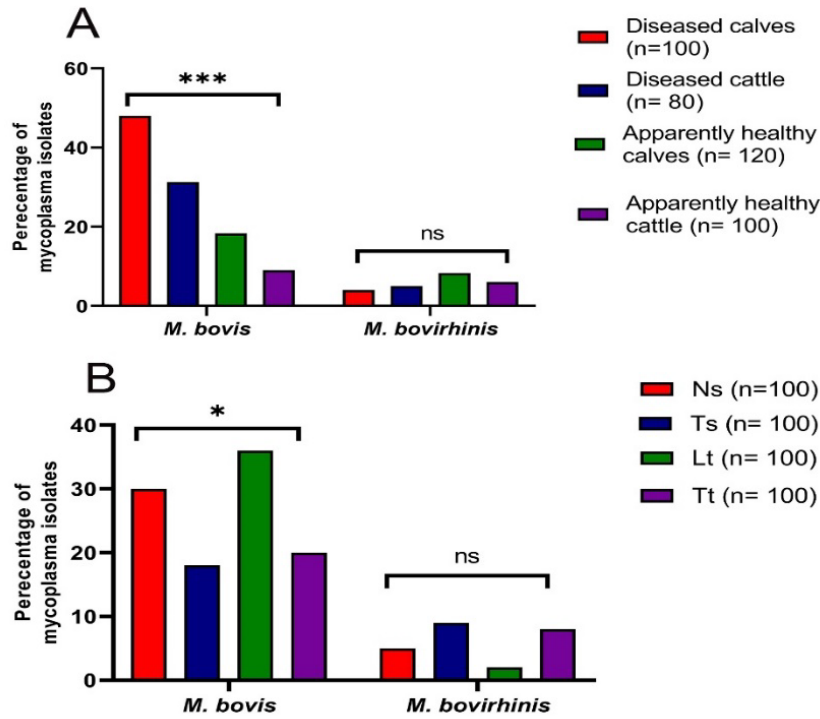
Figure 1. Prevalence of M. bovis and M. bovirhinis isolates in various samples’ sources ( A ) and types ( B ). Ns: nasal swabs, Ts: tracheal swabs, Lt: lung tissues; Tt: tracheal tissues, * p < 0.05, *** p < 0.001, ns: non-significant.